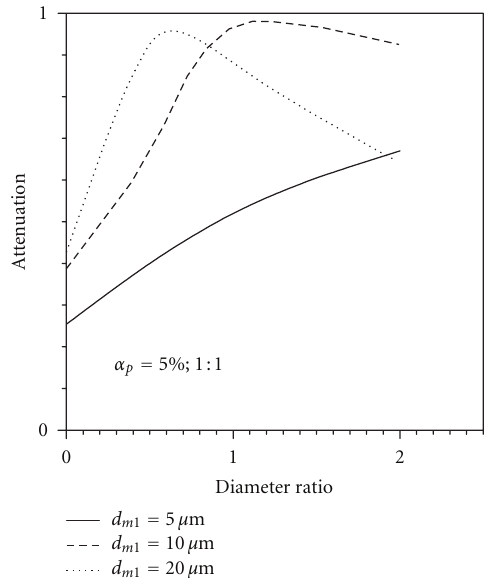
Figure 17: Nondimensional attenuation as function of particle diameter ( d m 2 : d m 1 ), for a 1:1 loading distribution for two sets of particles at total loading of 5%, reference motor, acceleration